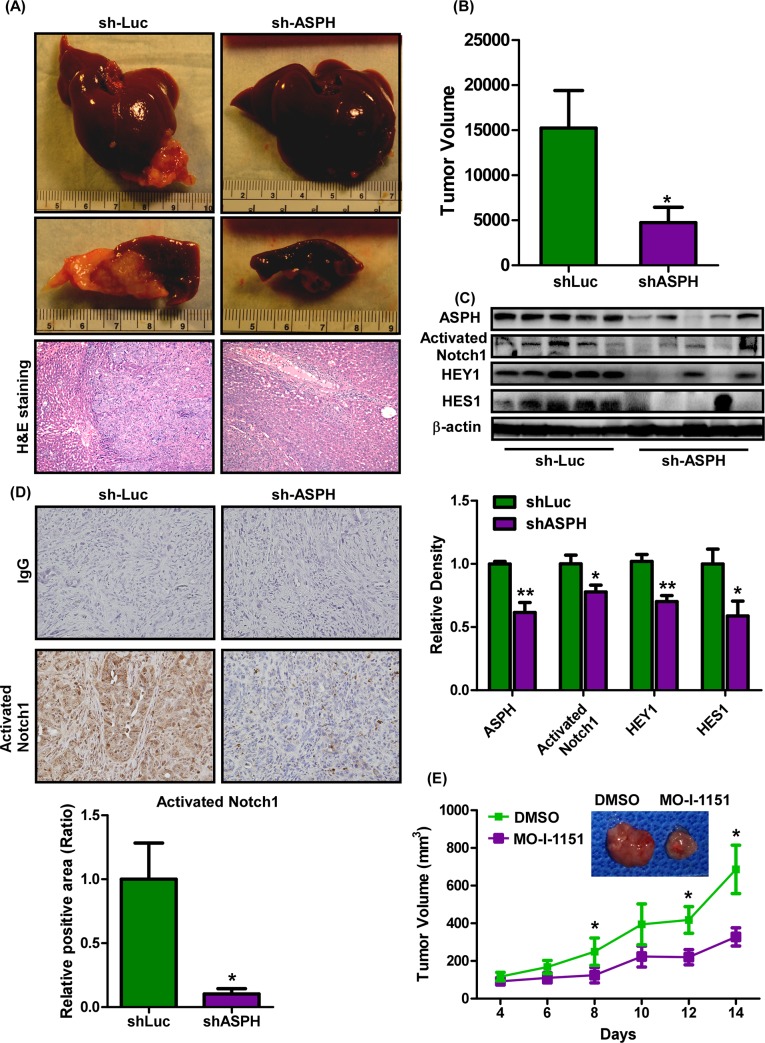
Anti-tumor effects of targeting ASPH in a rat intrahepatic CCA model of intrahepatic growth as well as subcutaneous tumor growth in nude mice xenograft with a human H1 CCA cell line.(A) Gross morphology and histology (H&E staining) of rat livers inoculated with BDE-Neu-CL#24-shRNA-luciferase (shLuc) or BDE-Neu-CL#24-shRNA-ASPH (shASPH). (B) Tumor volume in rat livers of BDE-Neu cell clone (#24) generated intrahepatic CCA tumors. (C) (Upper) Expression of ASPH, activated Notch1, HES1, and HEY1 in shLuc and shASPH treated in BDE-Neu-CL#24 generated tumors. (Lower) Relative expression abundance was shown by the density measurements. (D) (Upper) Representative IHC images of activated Notch1 in shLuc and shASPH treated rat intrahepatic CCA. (Lower) Number of positive nuclei containing an activated Notch1 signal was calculated. (E) H1 xenograft tumor growth rate and progression was determined in nude mice receiving DMSO or MO-I-1151 treatment every other day at 25 mg/kg. **, p <0.01; *, p <0.05.